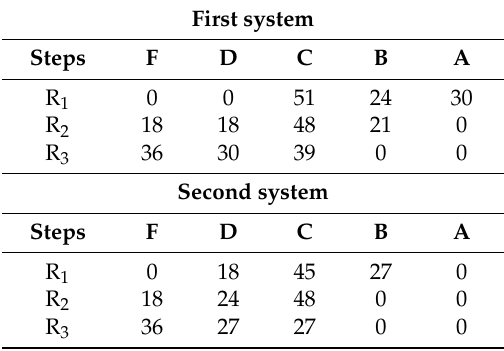
Table 3. Assessment of the past cases of the CBR systems.